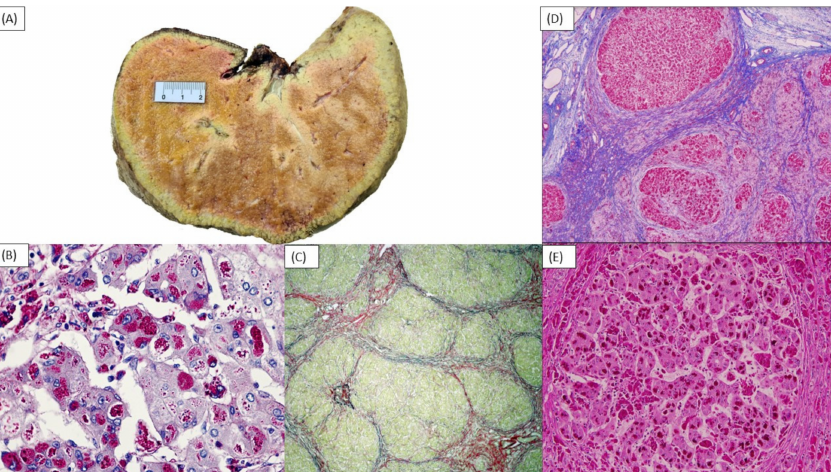
Figure 1. Macro and micro aspects of the explanted liver of Case 1 ( A – C ) and Case 2 ( D , E ). ( A ) Patient’s liver showing accumulation of amylopectin. Ruler shows the measurement in cm. ( B ) Hematoxylin and eosin staining showing intracellular hydropic degeneration and cytoplasmic inclusions, and ( C ) periodic acid-Schiff-diastase (PAS-D) staining. Hepatocytes were stained with PAS and were mostly digested by PAS-D. ( D ) 20 × magnification: Trichrome stain shows features of liver storage disease and portal and periportal bridging fibrosis. ( E ) 100 × magnification: Hematoxylin and eosin staining showing intracellular hydropic degeneration and cytoplasmic